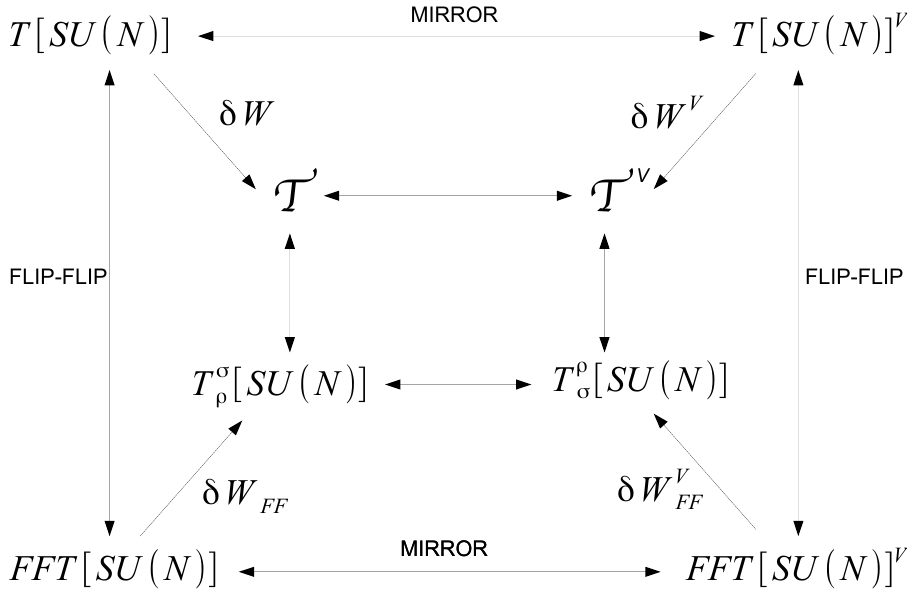
Figure 4 . Deformed duality web for T [SU( N